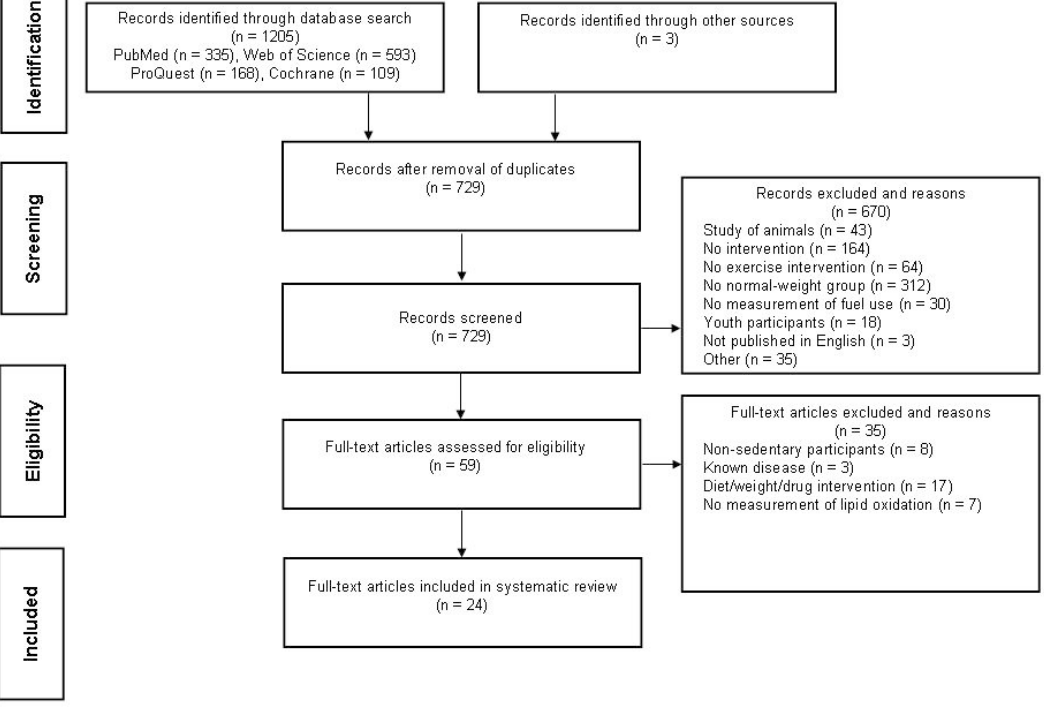
Figure 2. Flow diagram depicting the study-selection process that was used to conduct this systematic